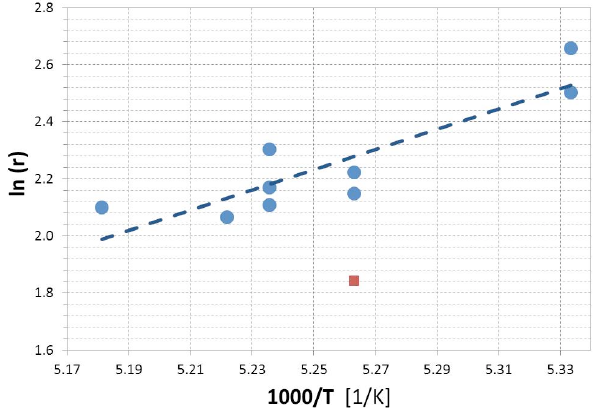
Figure 6. Arrhenius plot of r corresponding to r = J evnet (H 2 O) / J ev (HCl•6H 2 O) leading to a slope of Fig. 6. Arrhenius plot of r corresponding to r = J net ev q 3544.7 corresponding to Ε asub (H 2 O) – E asub (HCl•6H 2 O) = -29.5 ± 9.6 kJ mol -1 . The slope has been (H 2 O)/ J ev (HCl 6H 2 O) leading to a slope of 3544.7 correspond- q evaluated without taking into account the outlier (red square). ing to E sub a (H 2 O) − E sub a (HCl 6H 2 O) =− 29.5 ± 9.6kJmol − 1 . The slope has been evaluated without taking into account the outlier (red